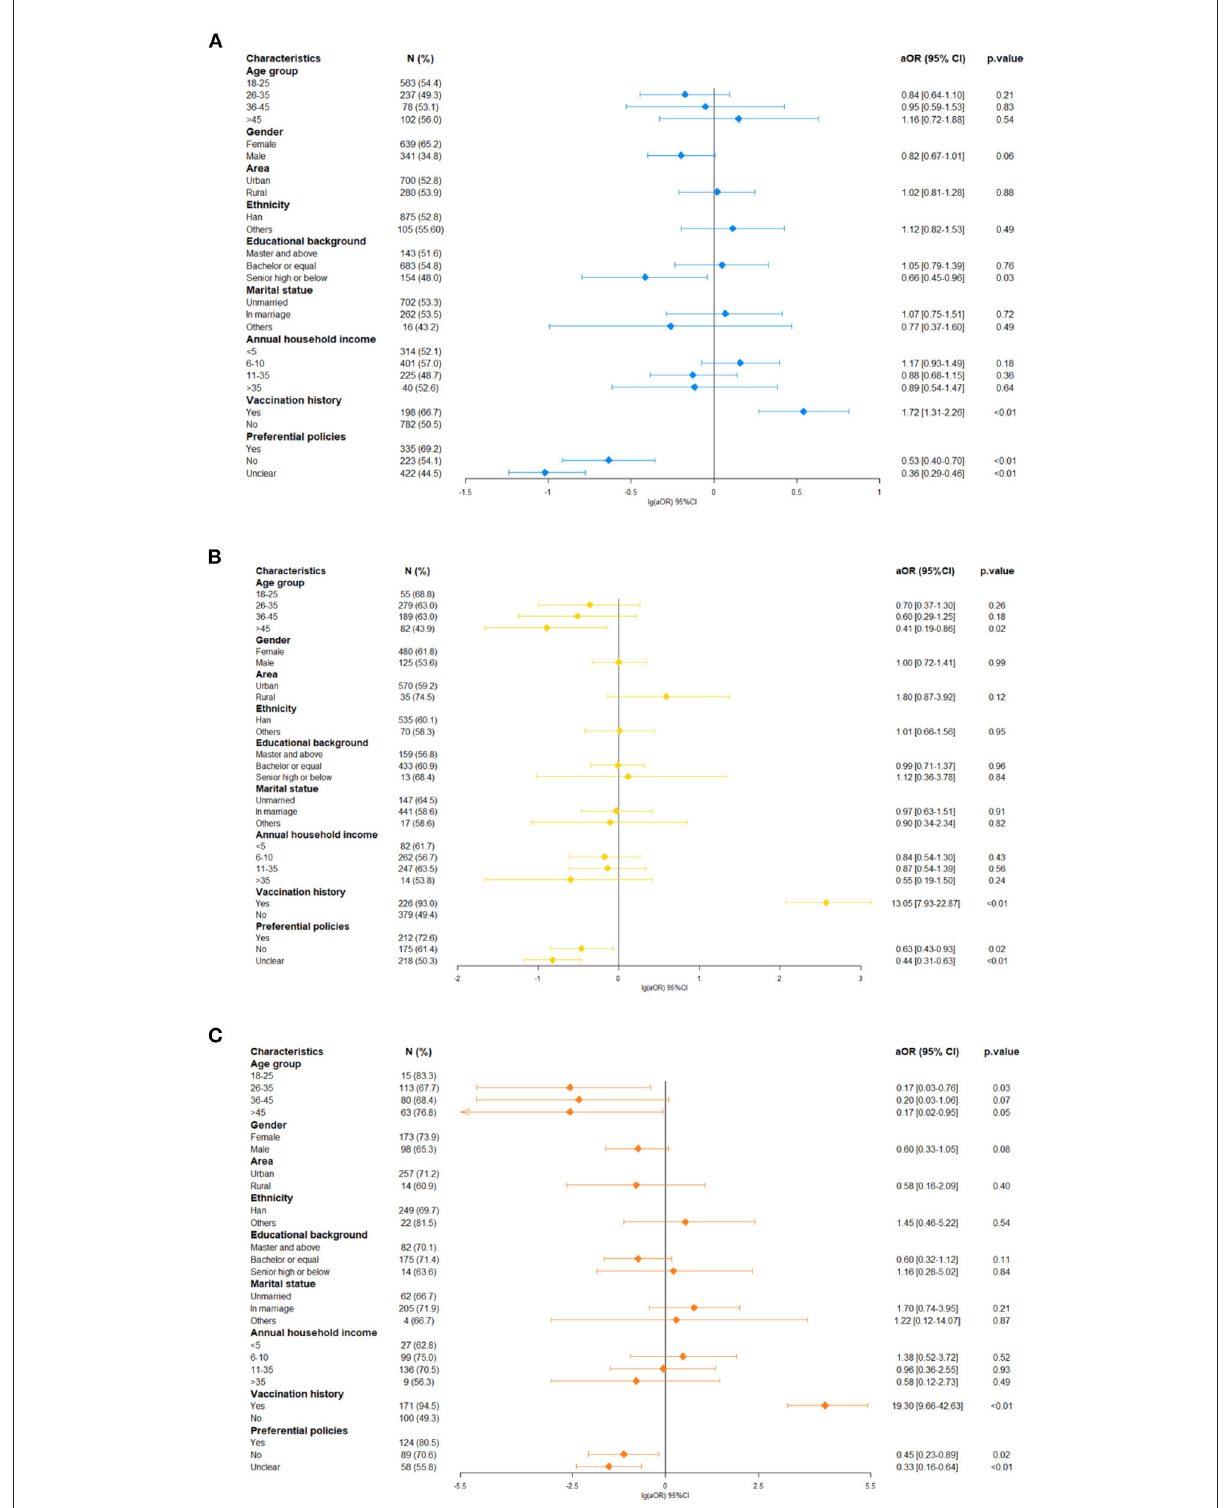
FIGURE3 Factors associated with positive attitudes toward influenza vaccination. (A) In general population group, (B) in healthcare worker group, and (C) health administrator